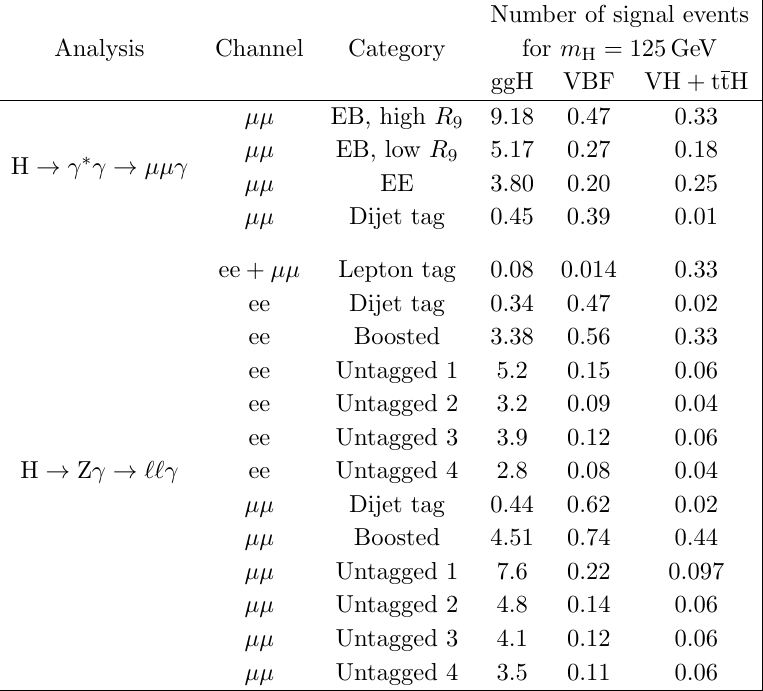
(cid:13) (cid:3) (cid:13) (cid:22)(cid:22)(cid:13) and H Z (cid:13) ‘‘(cid:13) processes in ! ! ! !